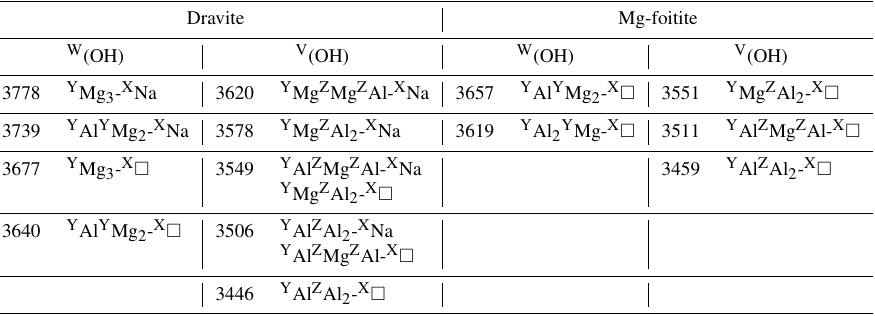
Table 2. Proposed interpretations of experimental bands in synthetic dravite and magnesio-foitite. Experimental frequencies (cm − 1 ) are those of samples EB28 and MF2 of Berryman et al. (2016), except the 3677cm − 1 frequency from Gourdant and Robert (1997). The broad component at 3511cm − 1 in Mg-foitite likely corresponds to multiple configurations.